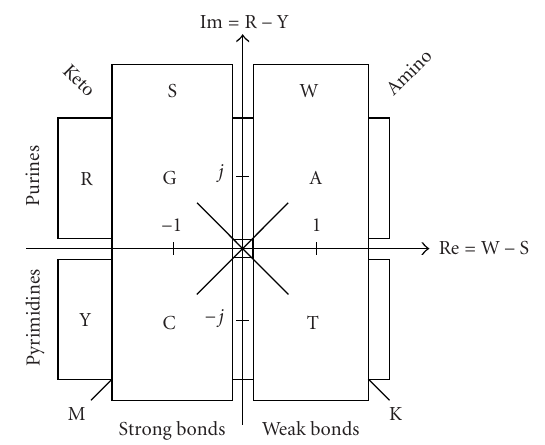
Figure 1: Nucleotide quadrantal complex